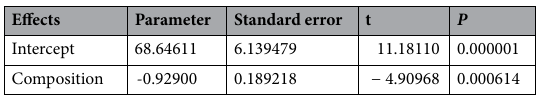
Table 6. Regression analysis for L* values in terms of nanosilver loading.